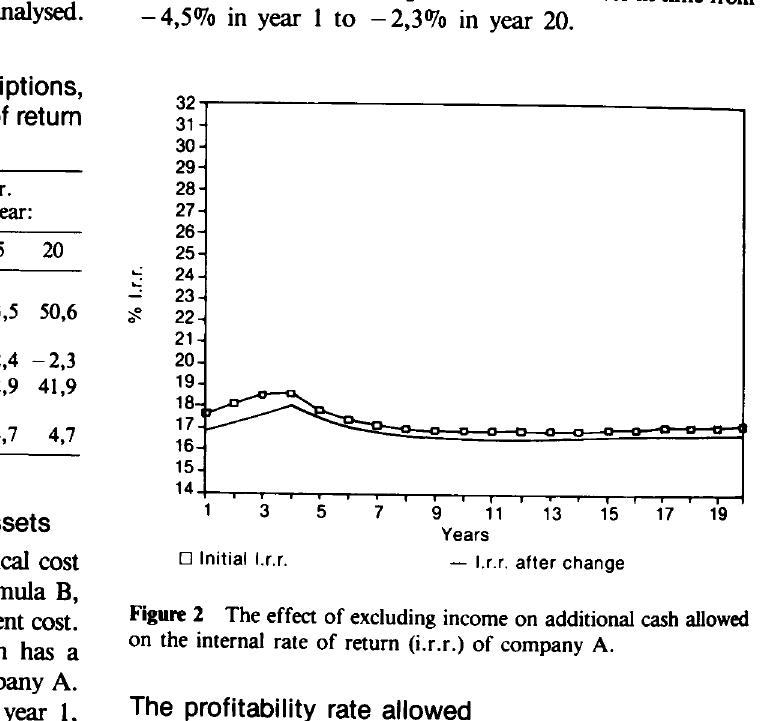
Figure 2 The effect of excluding income on additional cash allowed on the internal rate of return (i.r.r.) of company A.